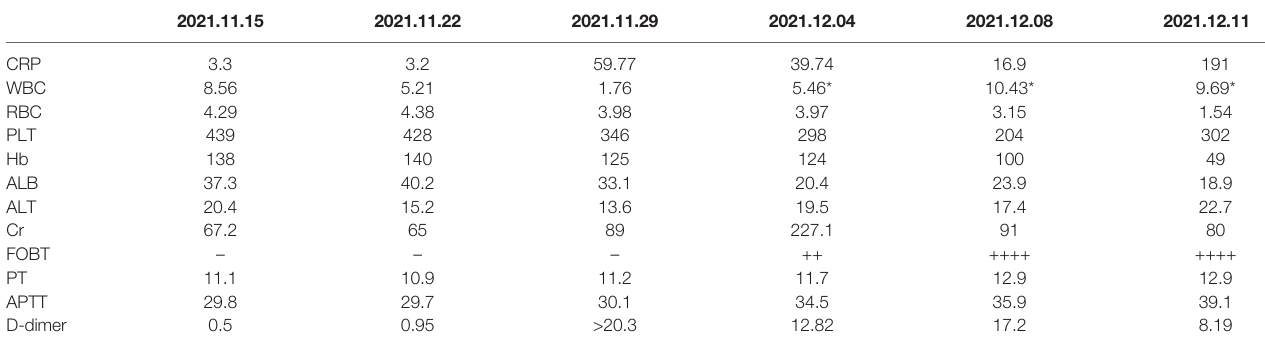
TABLE 1 | Laboratory test results of the baseline and follow-up of the